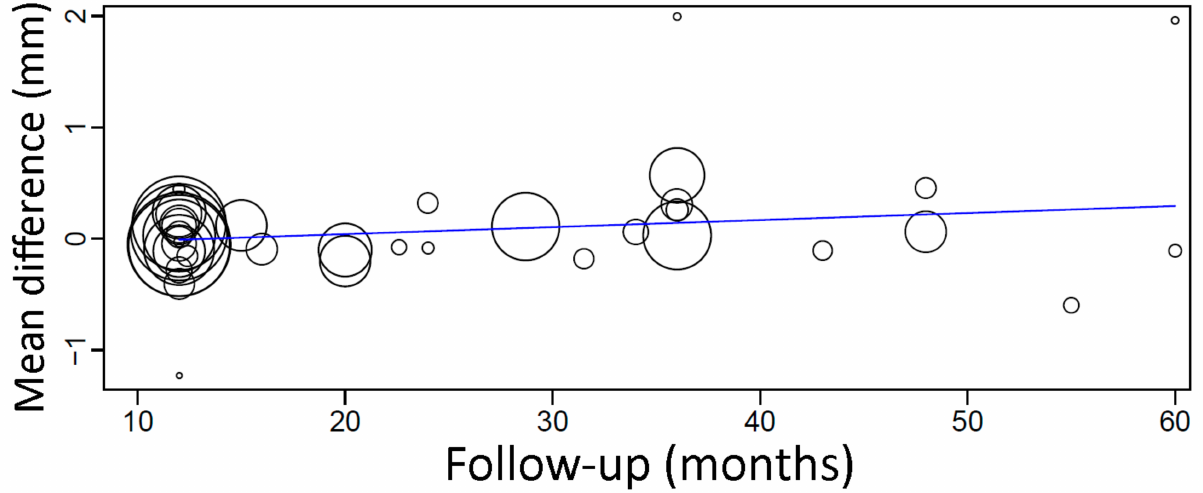
Figure 8. Scatter plot for the meta-regression with the association between follow-up (in months) and MBL mean difference between implants placed in fresh extraction sockets and healed sites. Every circle represents a study, and the size of the circle represents the weight of the study in the analysis.